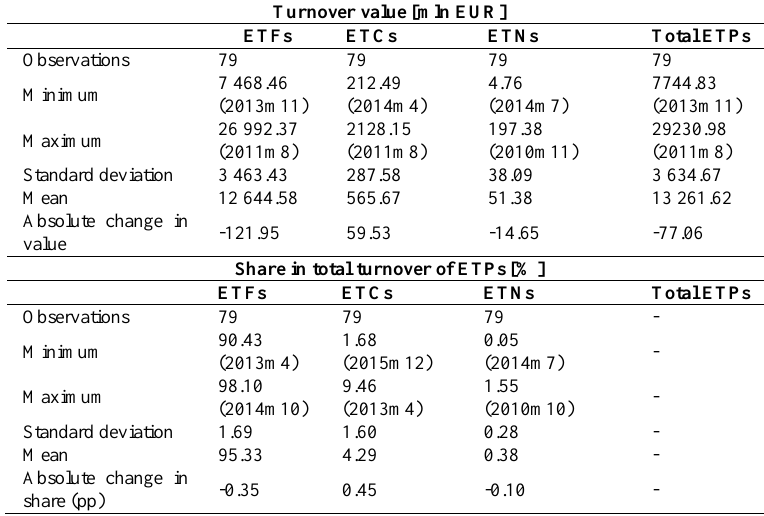
Table 3. Summary statistics on turnover of exchange-traded products in Germany. Monthly data for June, 2010 — December, 2016